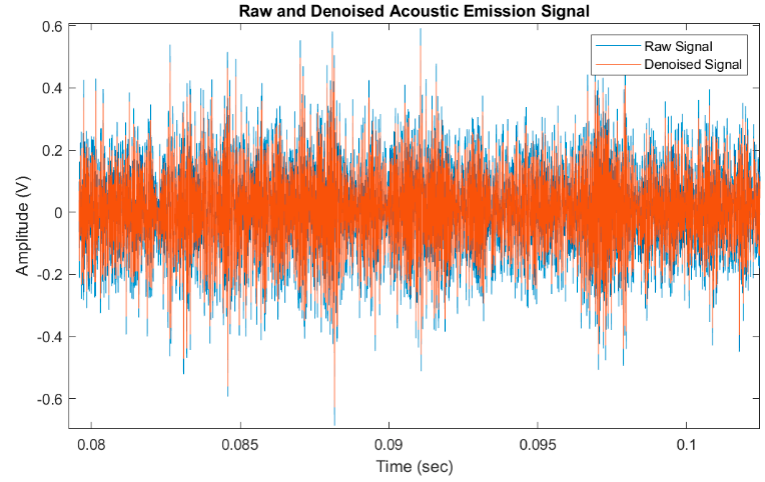
Figure 1. Raw and denoised acoustic emission signal.